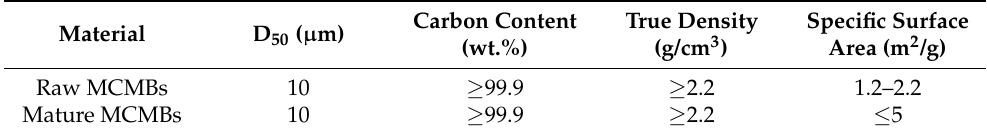
Table 1. Performance parameters of the raw and mature